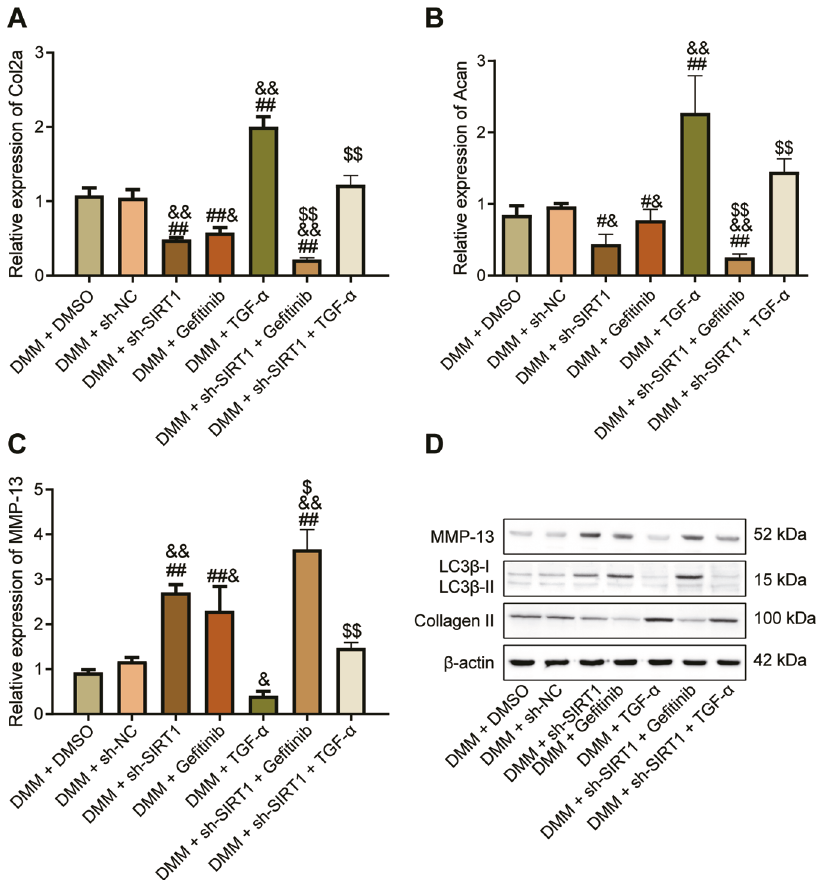
Fig. 7 Alteration of SIRT1/PTEN/EGFR axis regulates the process of OA in vivo. A qRT-PCR detection of Col2a gene expression in mouse chondrocytes in response to TGF- α and ge fi tinib. B qRT-PCR detection of Acan gene expression in mouse chondrocytes in response to TGF- α and ge fi tinib. C qRT-PCR detection of MMP-13 gene expression in mouse chondrocytes in response to TGF- α and ge fi tinib. D Western blot detection of MMP-13, LC3B-I, LC3B-II and Collagen protein expression in chondrocytes from mice with TGF- α and ge fi tinib interventions. # p < 0.05, ## p < 0.01 com p ared with the DMM + DMSO group. & p < 0.05, && p < 0.01 compared with the DMM + sh-NC group. $ p < 0.05, $$ p < 0.01 compared with DMM + sh-SIRT1 discarded. Cells were eluted with 3 × SDS loading buffer. The lysis buffer contained 50 mM heparin (pH 7.4), 150 nM NaCl, 1 mM EDTA, 1 mM EGTA,